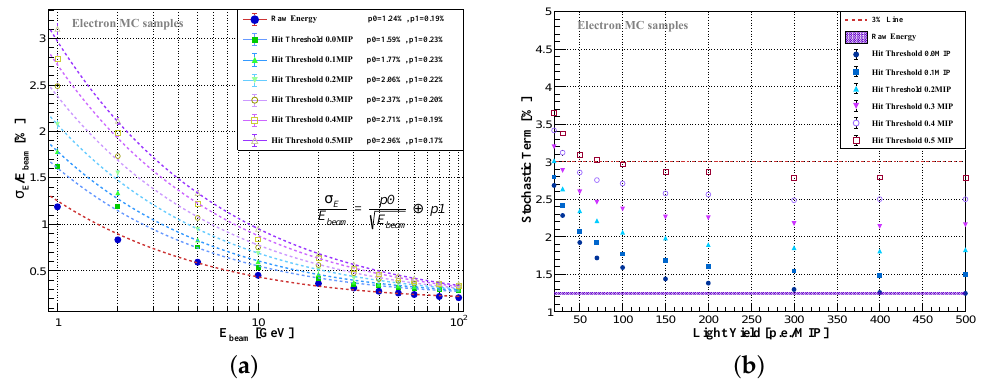
Figure 7. Energy resolution under different energy thresholds and crystal light yields. ( a ) The EM energy resolution when different energy thresholds are implemented on calorimeter hits. The light yield is set to 100 detected photons per MIP. ( b ) The stochastic term of the EM energy resolution with varying light yields (number of detected photons per MIP) and energy thresholds for hits.